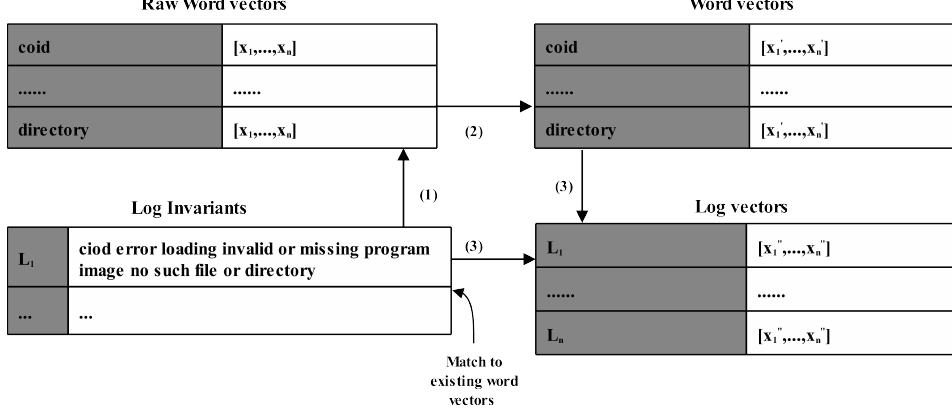
Figure 3. Example of